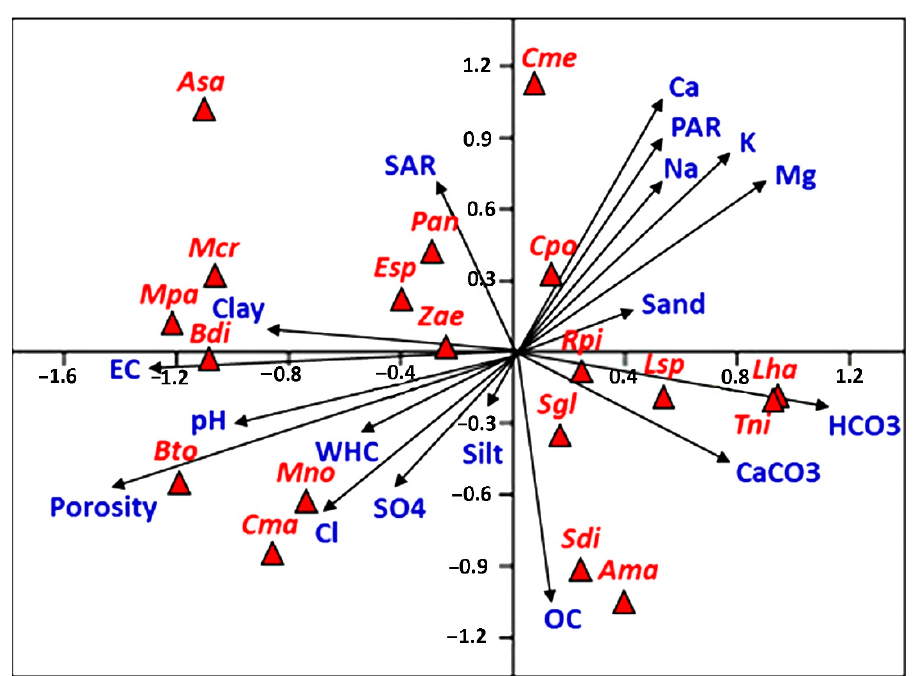
Figure 4. Canonical Correspondence Analysis (CCA) biplot of species–soil variable. EC: electrical conductivity, OC: organic carbon, SAR: sodium adsorption ratio, PAR: potassium adsorption ratio,